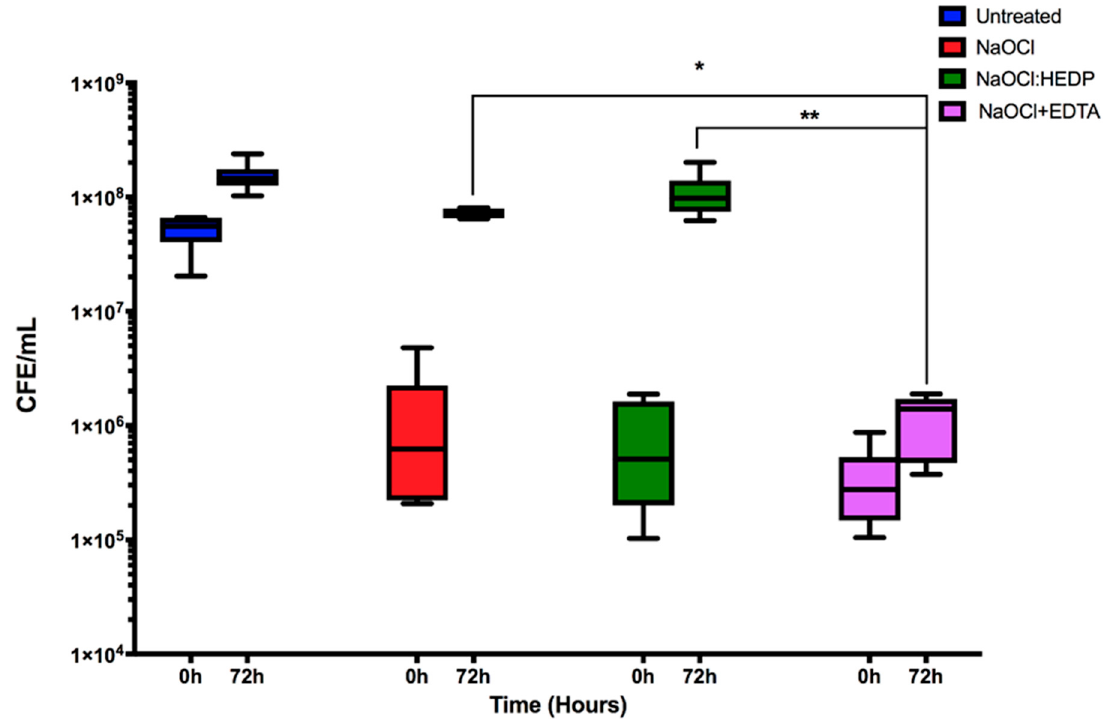
Figure 4. The effect of the three endodontic irrigants on E. faecalis in pre-formed 24 h dual-species biofilm. NaOCl alone, NaOCl:HEDP and NaOCl + EDTA were used to treat mixed species biofilms and E. faecalis quantified. Box and whisker plot of CFE at 0 h and 72 h for each treatment. Values were plotted as log10 on the Y axis. Statistical significance between the three treatment conditions at 72 h was presented as * p < 0.05, ** p < 0.01. Results represent data from three independent experiments.